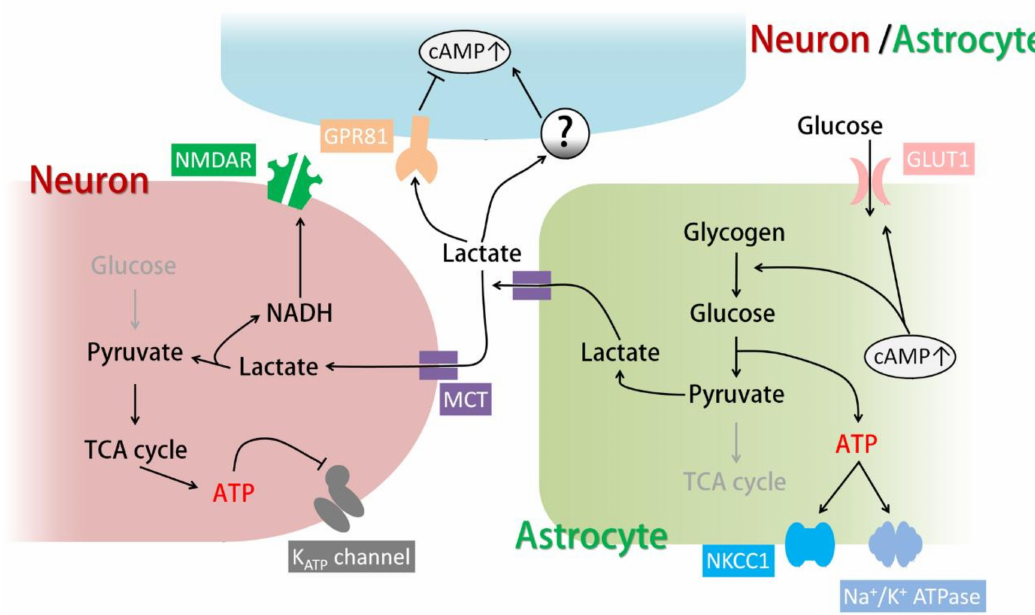
Figure 1. Energy metabolism and lactate shuttling between astrocytes and neurons. Astrocytic cAMP increases glucose uptake and glycogenolysis, triggering glycolysis and energy production. ATP produced from glycolysis is essential for K + uptake by Na-K-Cl cotransporter 1 (NKCC1) and Na + /K + ATPase. In the meantime, pyruvate in astrocytes is converted into lactate and shuttled to neurons via monocarboxylate transporters (MCTs). Lactate is converted into pyruvate for energy production in neurons and deactivates the K ATP channel, resulting in an increase in neuronal excitability. The co-product NADH (reduced form of nicotinamide adenine dinucleotide) has been shown to be important for N-Methyl-D-aspartic acid receptor (NMDAR) activation, which is important for synaptic plasticity. In addition, extracellular lactate can activate G-protein-coupled receptor 81 (GPR81) and unknown targets to either up- or down-regulate cAMP levels in neurons and astrocytes. Grey arrows and texts indicate that the processes shown are less active. Arrows indicate transference or conversion of molecules, or activating pathways. T-bars indicate inhibiting